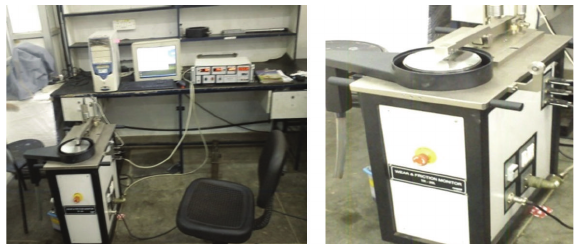
Figure 9: Pin on disc